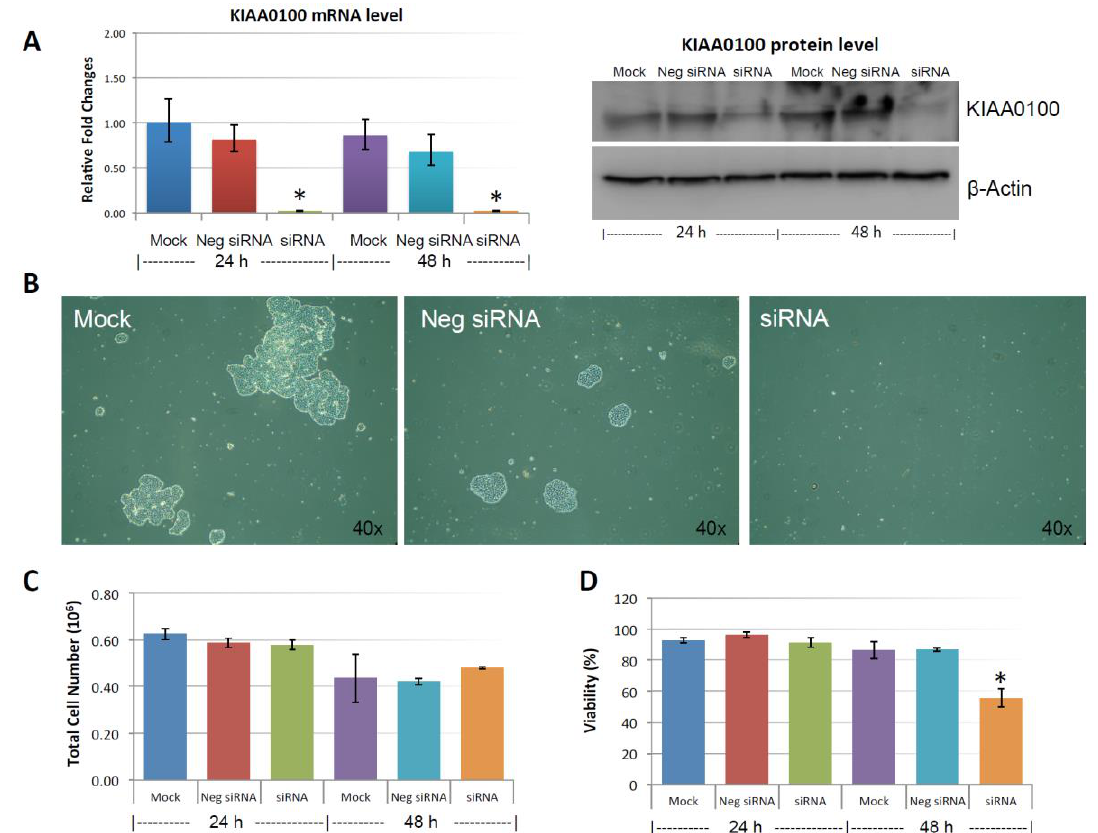
Figure 3. Knocking-down KIAA0100 reduces cell aggregation and viability in suspension. MDA-MB-231 cells were reverse transfected with KIAA0100 siRNA and maintained in suspension culture plate coated with poly-HEMA. ( A ) 24 h and 48 h after transfection, both mRNA and protein levels of KIAA0100 in cell treated with KIAA0100 siRNA were examined by qPCR and Western blot. Both mRNA and protein levels were significantly reduced compared to the cells treated with negative siRNA as well as mock controls (*, p < 0.05); ( B ) cell aggregation in suspension upon KIAA0100 silencing was significantly reduced compared to the cells treated with negative siRNA and mock control; ( C ) no significant difference in total cell number counts between cells treated with KIAA0100 siRNA and controls in 24 and 48 h after the treatment by ViaCell ( p > 0.05); ( D ) cell Viability (in percentage) in 24 and 48 h after treatment. No significant cell viability difference in 24 h ( p > 0.05). However, silencing the expression of KIAA0100 resulted in significant drop in cell viability 48 h after treatment (*, p < 0.05).